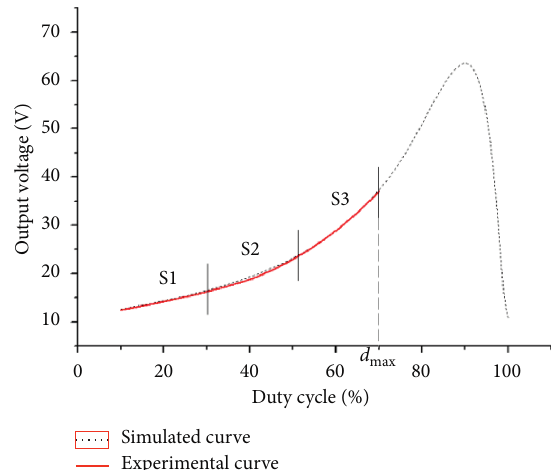
Figure 6: Three-level boost converter operating